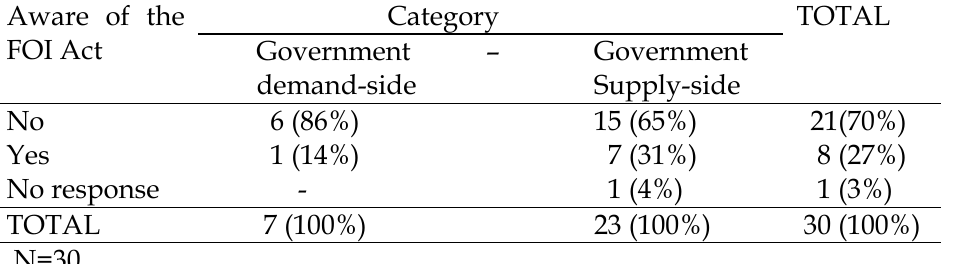
Table 4: Government Respondents Who Have Faced an FOI